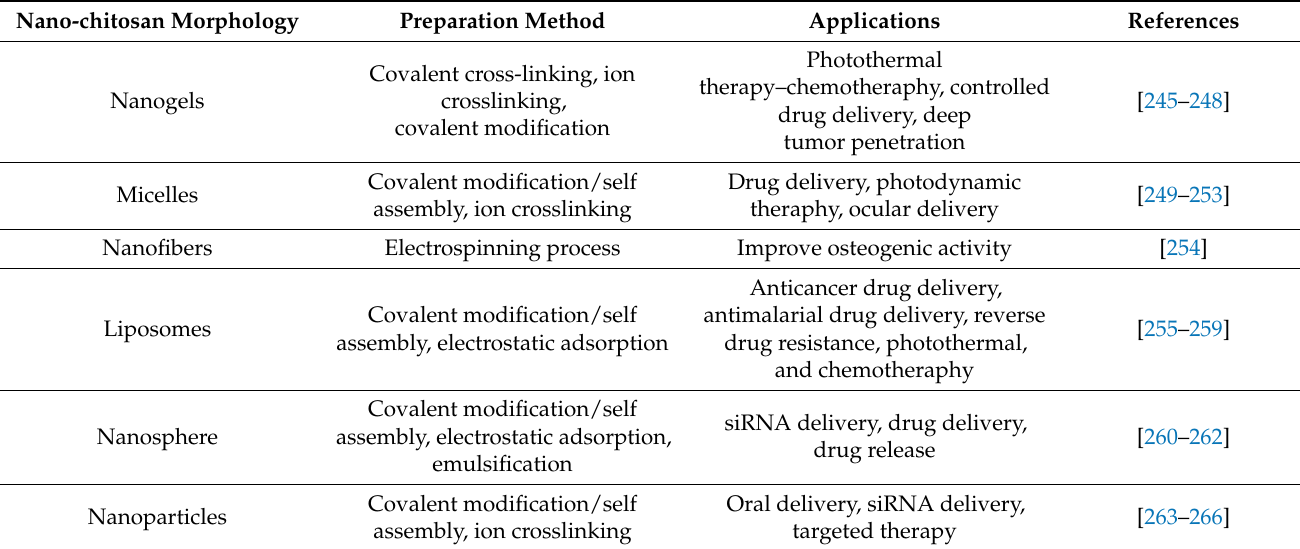
Table 2. Various nano-chitosan morphologies and their medical